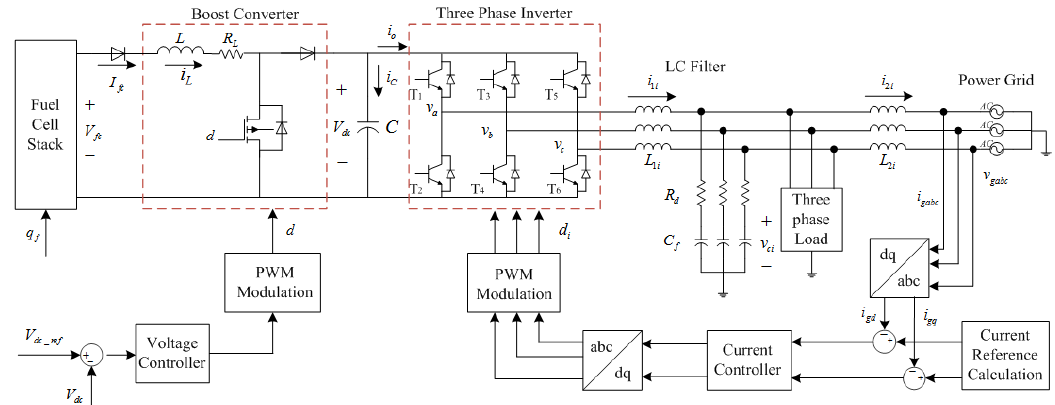
Figure 10. System configuration of the power conditioning